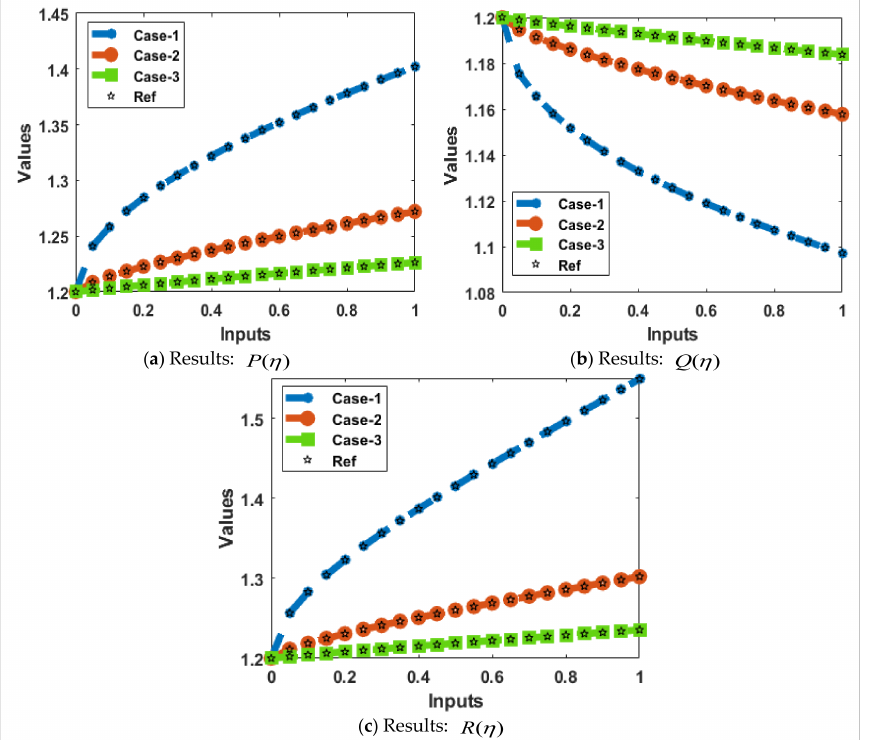
Figure 6. Matching of the results based on the dynamical FFSCS.